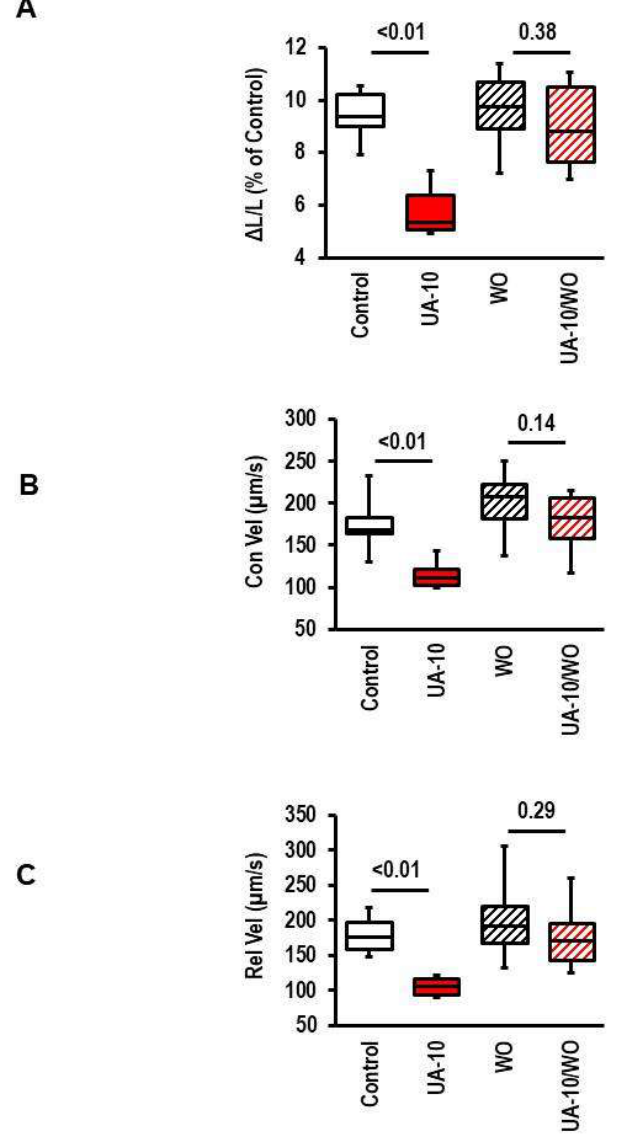
Figure 7. Effect of uric acid (UA) withdrawn for cell shortening measurements. Cells were exposed to UA for 24 h and cell shortening was analyzed in the presence of UA or after 15 min of the withdrawing of UA before starting to measure the cell shortening (WO). Data show the effects on cell shortening (( A ); ∆ L/L), contraction velocity (( B ); Con Vel), and relaxation velocity (( C ); Rel-Vel). Data are expressed as bars and whiskers with median, 25% quartile, 75% quartile indicated by bars, and complete range by whiskers. Statistical analysis is based on Student t -tests and exact p -values are indicated. Data are means from n = 10 (each) preparations (rats), with 4 cell culture dish per preparation and 9 cells evaluated per cell culture dish. Statistical analysis is based on preparations.